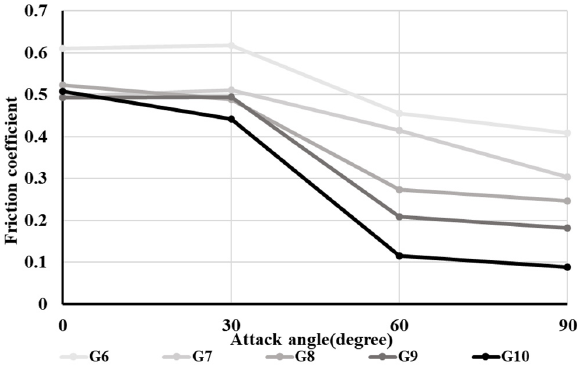
Figure 8. The relationships between attack angles and frictional coefficients for different ground gears (G6–G10).